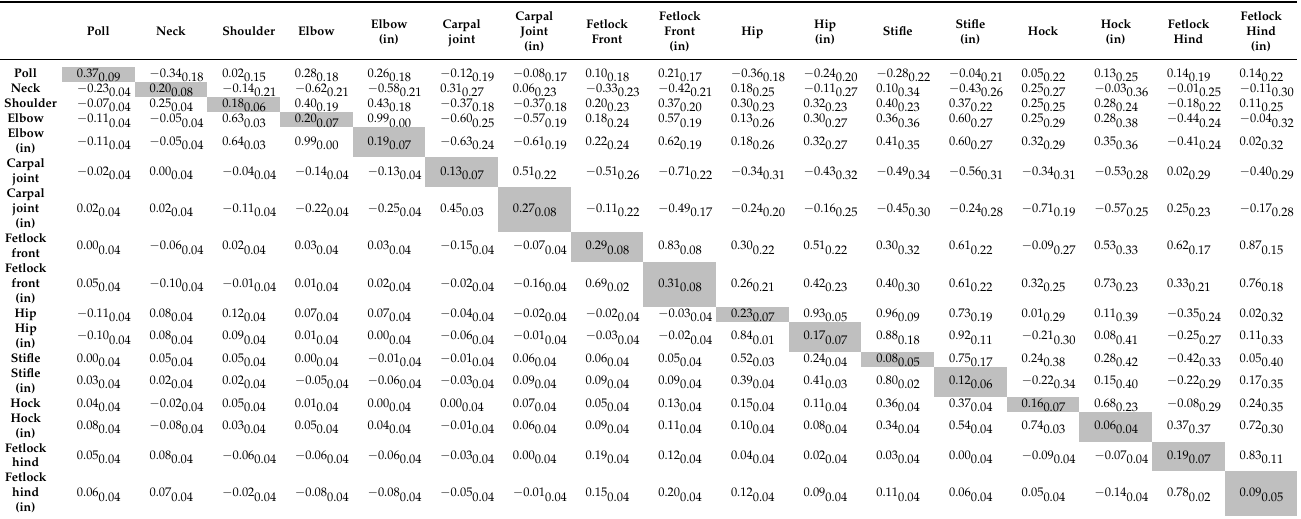
Table 6. Genetic correlations (above the diagonal), heritabilities (in the grey-coloured diagonal) and phenotypic correlations with their standard errors in subscript below the diagonal, for joint angle data derived from the horse shape space model.